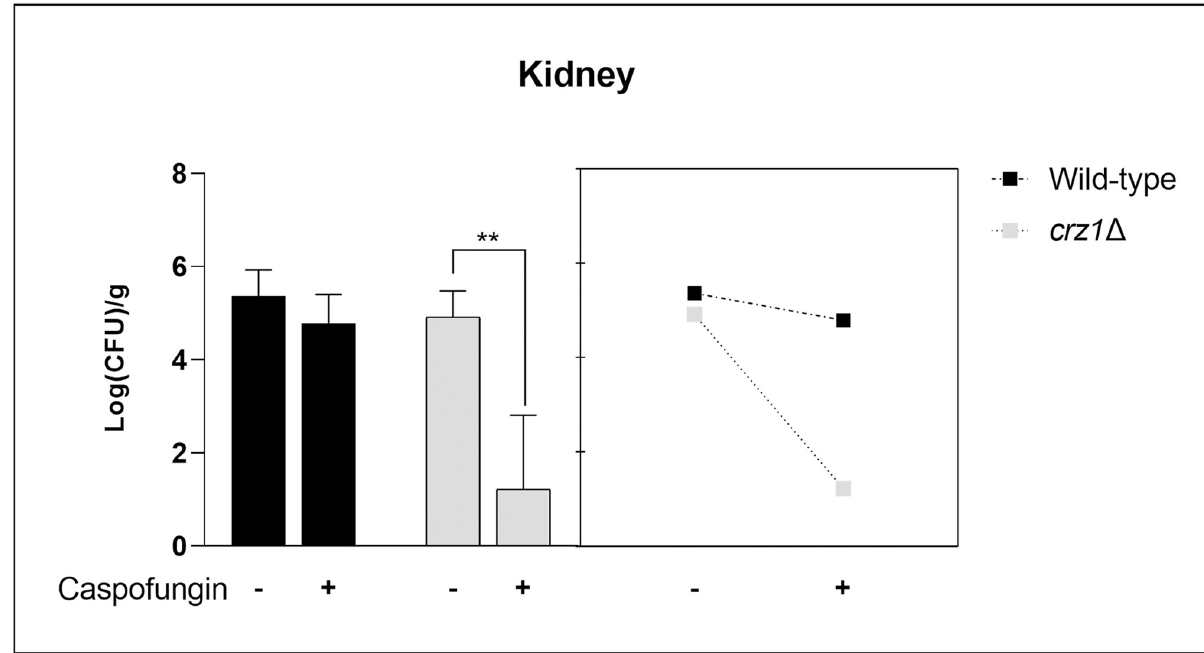
Fig 6. Fungal burden in kidneys from mice inoculated with 10 7 yeast cells of caspofungin-resistant C . glabrata 1875 wild-type or crz1 Δ strain and treated daily with (or without) caspofungin as indicated. Statistical analysis was carried out using the analysis of variance (two-way ANOVA) with post Tukey-Kramer